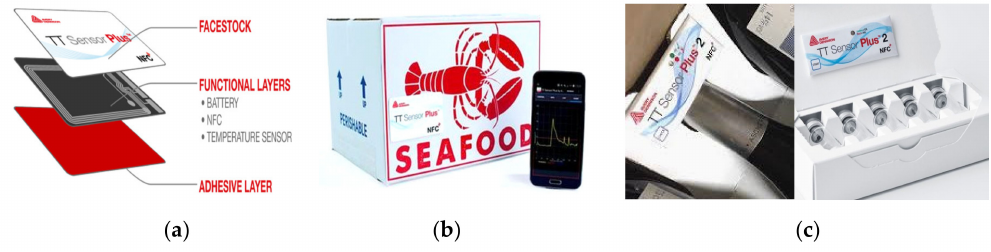
Figure 3. ( a ) Structure of the TT Sensor Plus TM smart label ( b ) to monitor the temperature of food products made available through NFC by using the mobile app; ( c ) TT Sensor Plus TM 2 label applied to a bottle of wine (left) or a pack of drugs